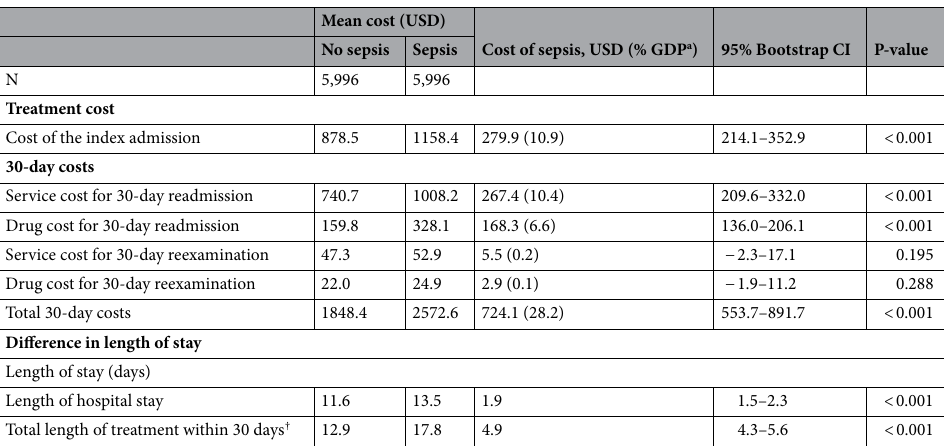
Table 2. Costs, length of hospital stay, and incremental estimates due to sepsis complication after surgery. 95% CI 95% Confidence interval; All estimates were calculated using a matched sample. § Compared to GDP per capita in Vietnam in 2018 (2,566 USD). † Includes length of hospital stay in the treatment and 30-day readmission periods.